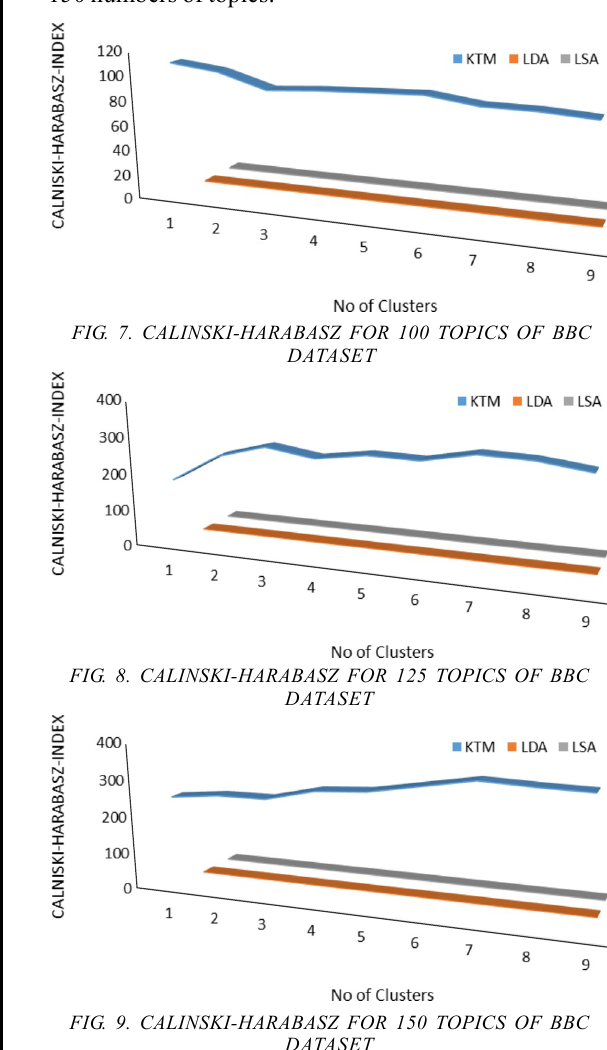
FIG. 9. CALINSKI-HARABASZ FOR 150 TOPICS OF BBC